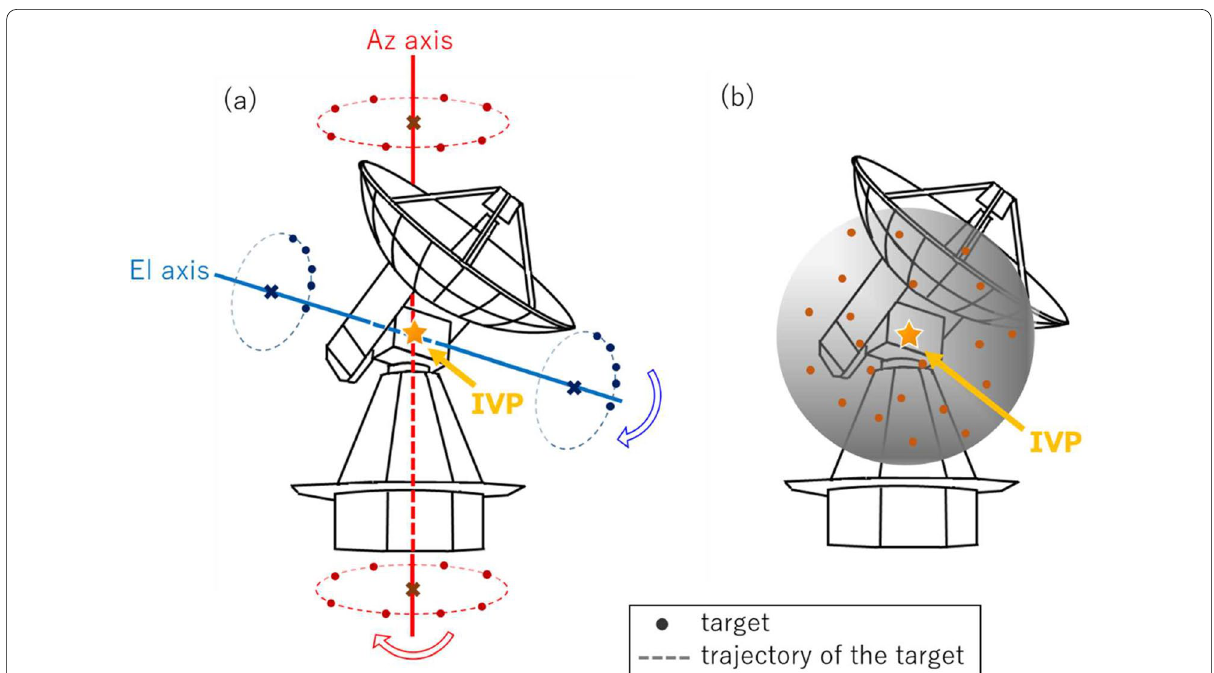
Fig. 3 Conceptual picture of how to estimate IVP. a Relation between rotation axes, IVP and target positions for axis method. El and Az axes are estimated with target positions indicated by blue and red dots, respectively; b relation between IVP and target positions for sphere method